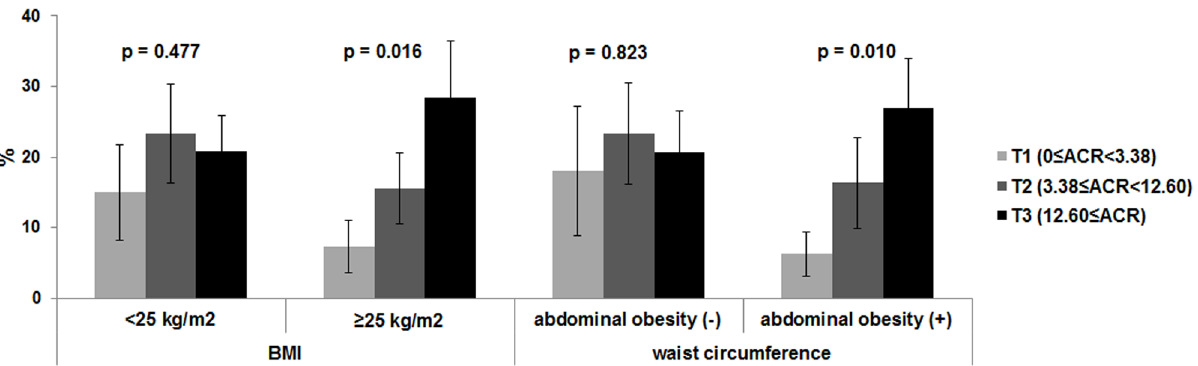
Figure 2. The relationships between albumin/creatinine ratio (ACR) tertiles and the prevalence of high intraocular pressure (IOP; $ 18 mmHg) in subgroups based on body mass index and abdominal obesity. The P values for trends are shown.